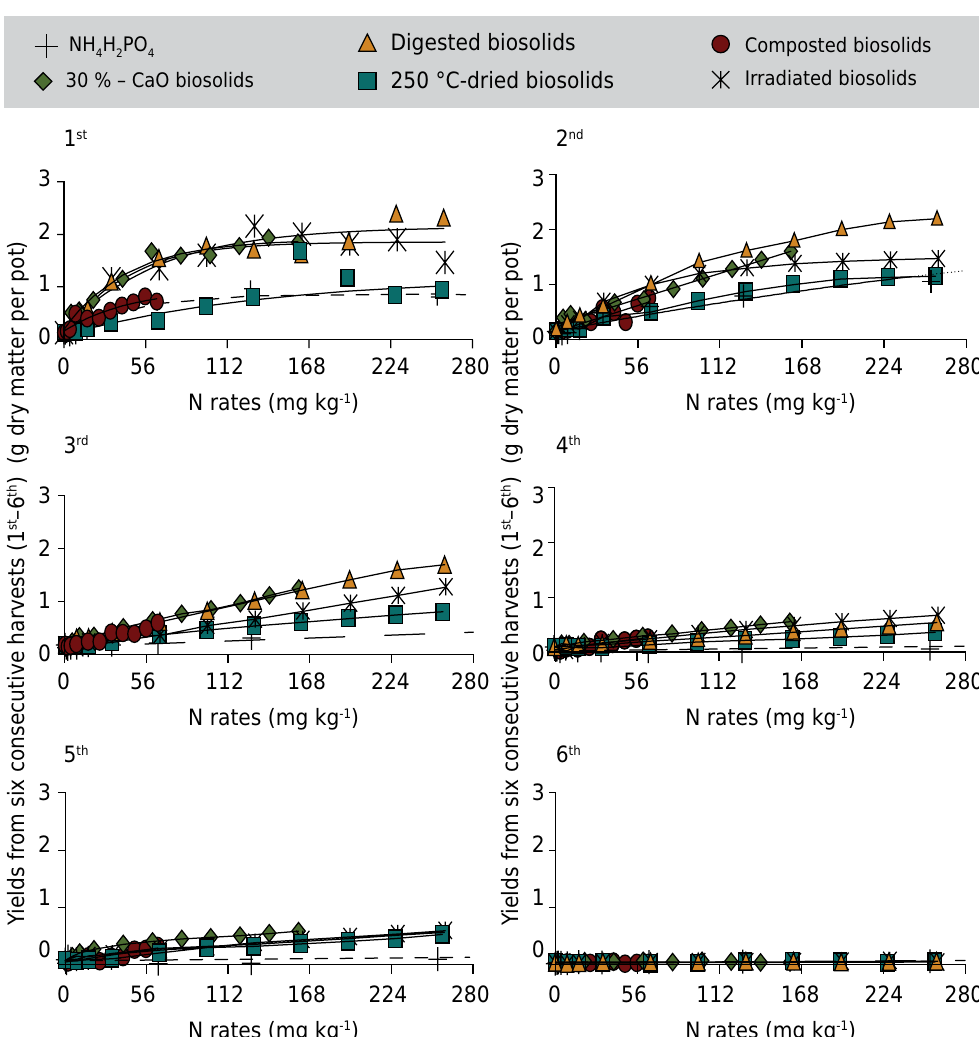
Figure 1. Yield responses to biosolids-N application and to NH 4 H 2 PO 4 + basal application in